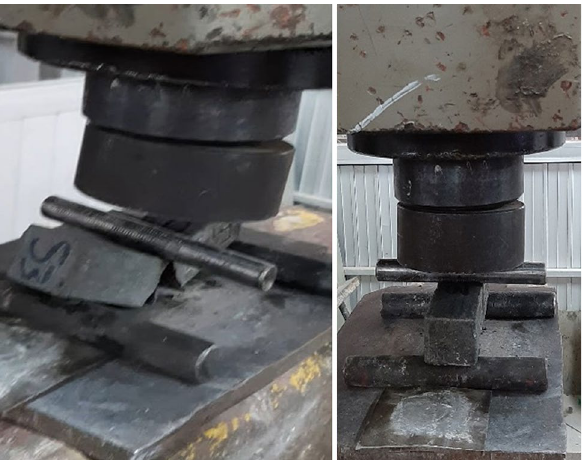
Figure 13. The used electrohydraulic bending and compression testing